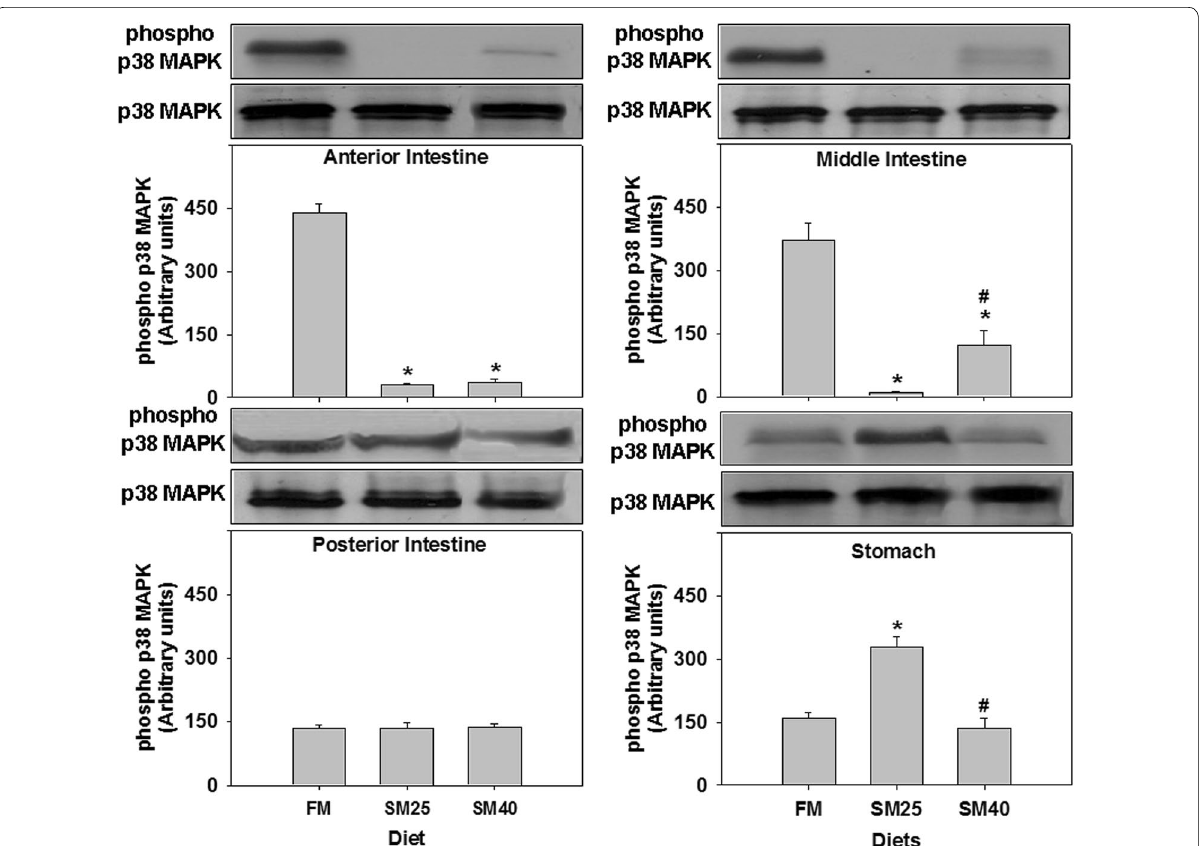
Fig. 2 Phosphorylation of p38 MAPK in the anterior, middle, posterior intestine and stomach of common dentex ( D. dentex ) under the FM, SM25 and SM40 diet treatment. Representative protein bands are shown on the top of the panel. Western blots are representative of at least three inde- pendent experiments with overlapping results and data represent mean different animals. * p < 0.05 compared to FM; # p < 0.05 compared to